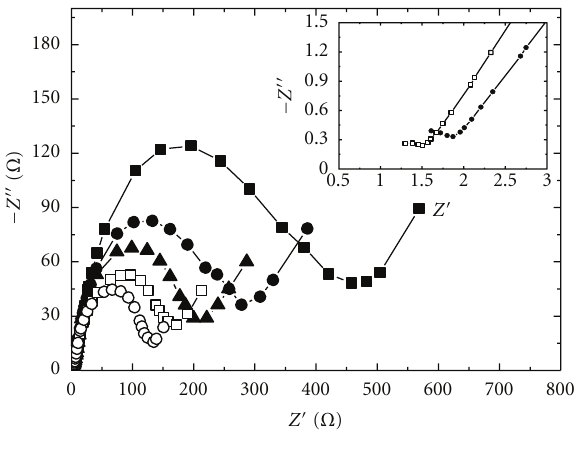
Figure 7: Nyquist plots at 10 ( (cid:7) ), 20 ( • ), 30 ( (cid:6) ), 40 ( (cid:2) ) y 50 ◦ C ( (cid:10) ) for the P5FNDIHS membrane in the acid form equilibrated with distilled water. Inset: zoom of the Nysquit plots at 20 ◦ C and 40 ◦ C in the high-frequency region.